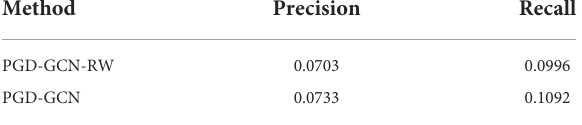
TABLE 10 Results of variants on